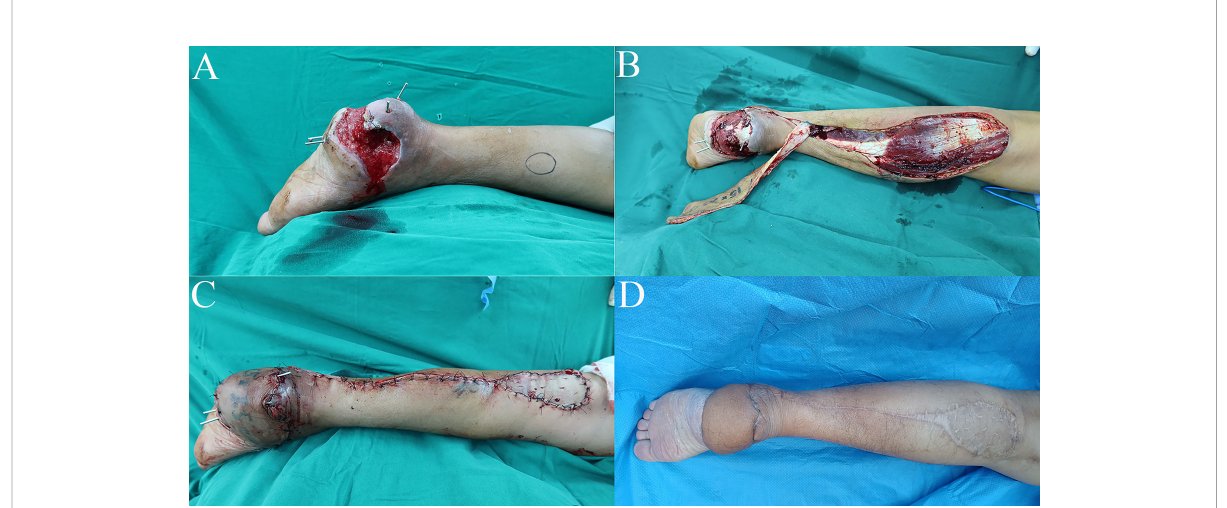
FIGURE 1 Case 1: Te distally based sural neurocutaneous fl aps for reconstruction of the heel soft tissue defect. (A) Diabetic wound at the heel. (B) Harvest of the distally based sural neurocutaneous fl ap. (C) The defect was reconstructed with a fl ap, and the donor site was covered with skin graft. (D) The fl ap and the donor site were completely healed at